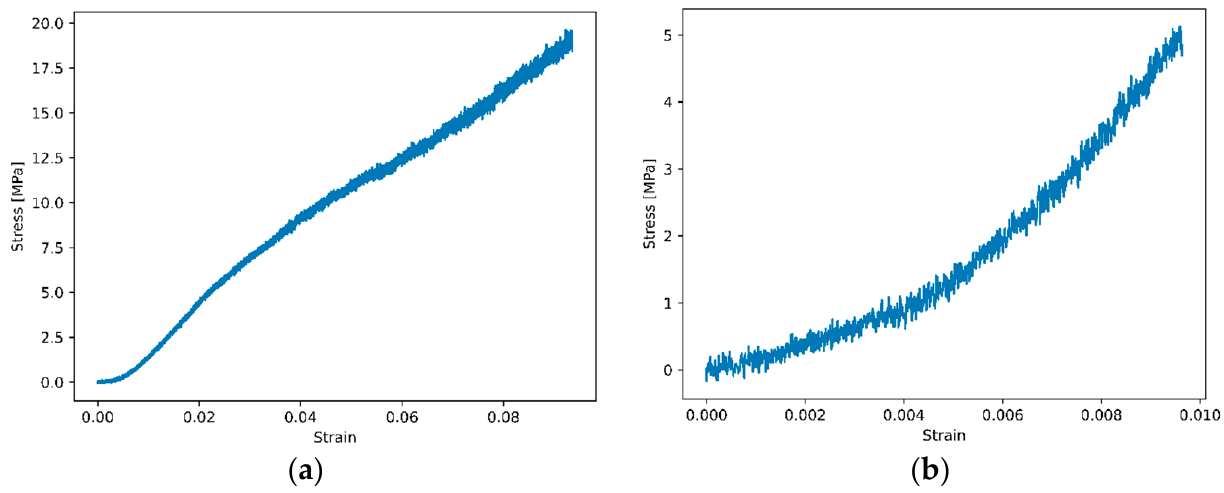
Figure 9. Stress–strain diagrams of ( a ) wet PAN-DMSO membrane and ( b ) dry PAN-DMSO membrane.